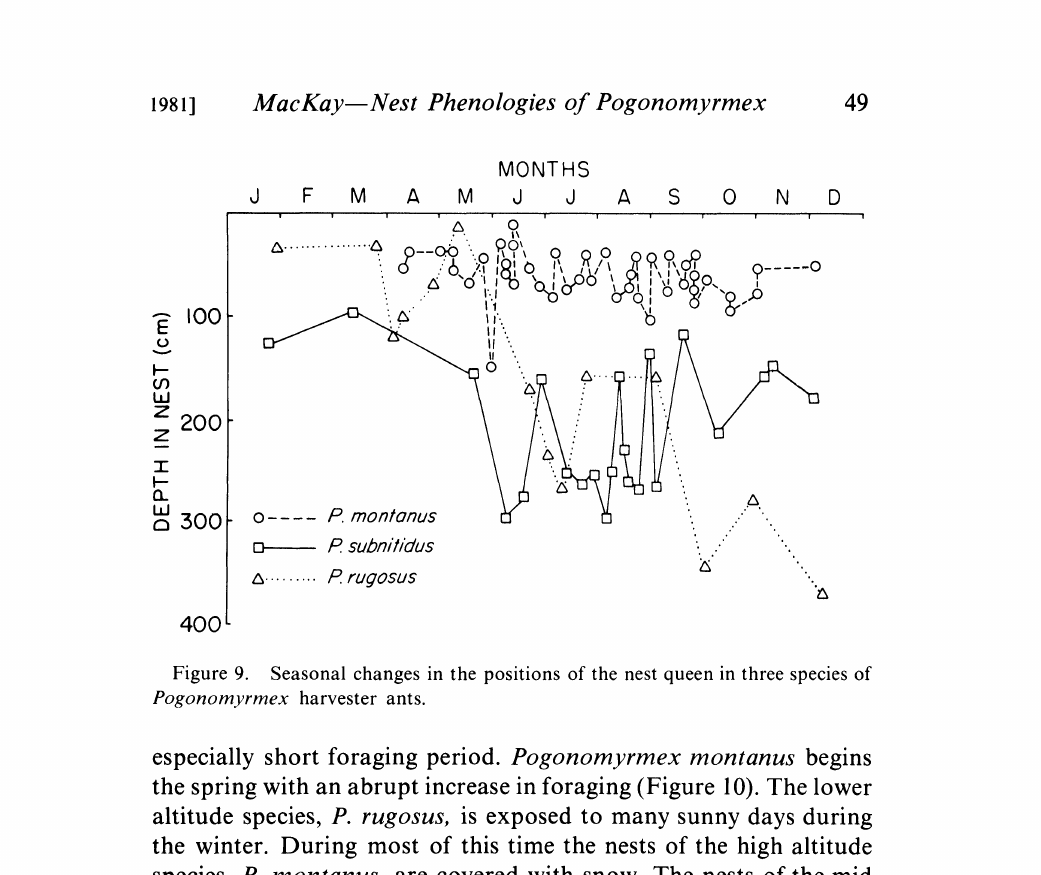
Figure 9. Seasonal changes in the positions of the nest queen in three species of Pogonomyrmex harvester